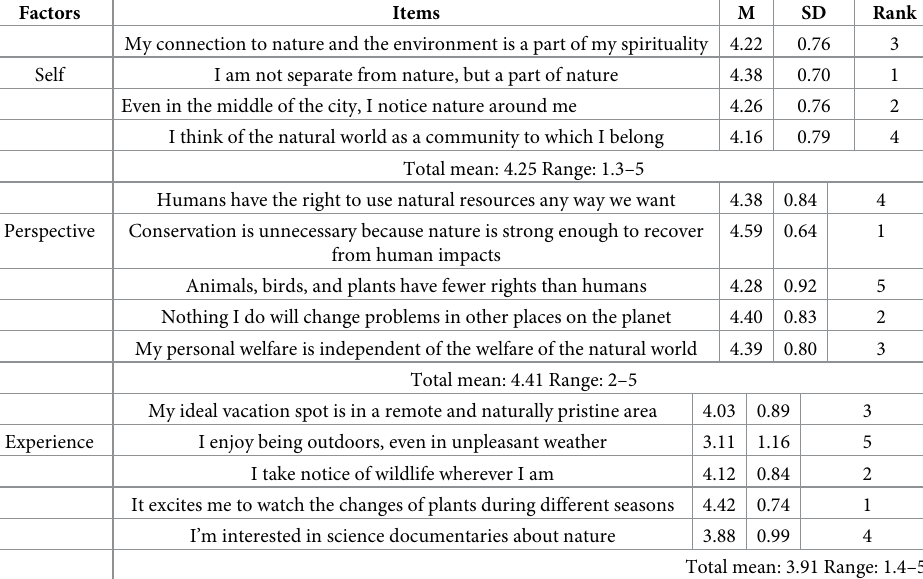
Table 5. Descriptive statistics of self, perspective,